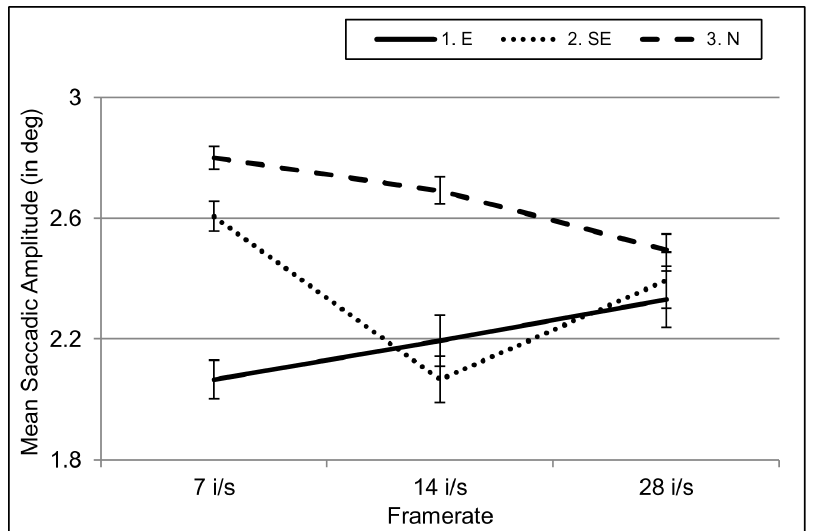
Figure 8. Interaction between Expertise and Framerate for saccadic amplitude in ELN videos. Experts made progressively longer and naı¨ve participants progressively shorter saccades as a function of increasing framerate. Semi-experts behaved like naı¨ve participants in the lowest framerate and like experts in the higher framerates.